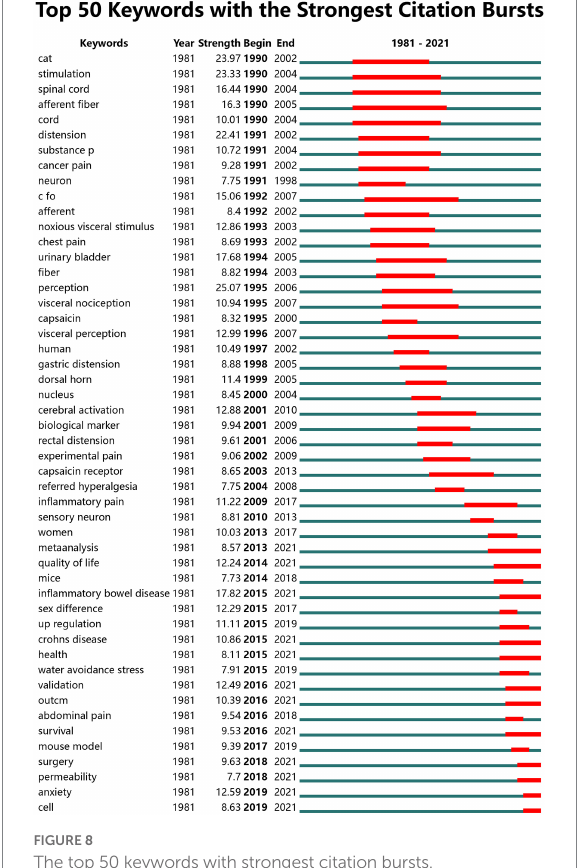
FIGURE 8 The top 50 keywords with strongest citation